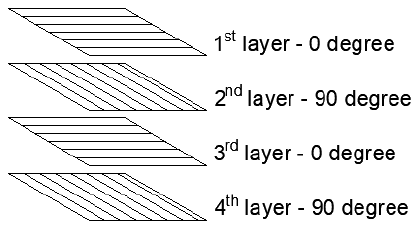
Figure 1. Schematic representation of sequential PALF layers.